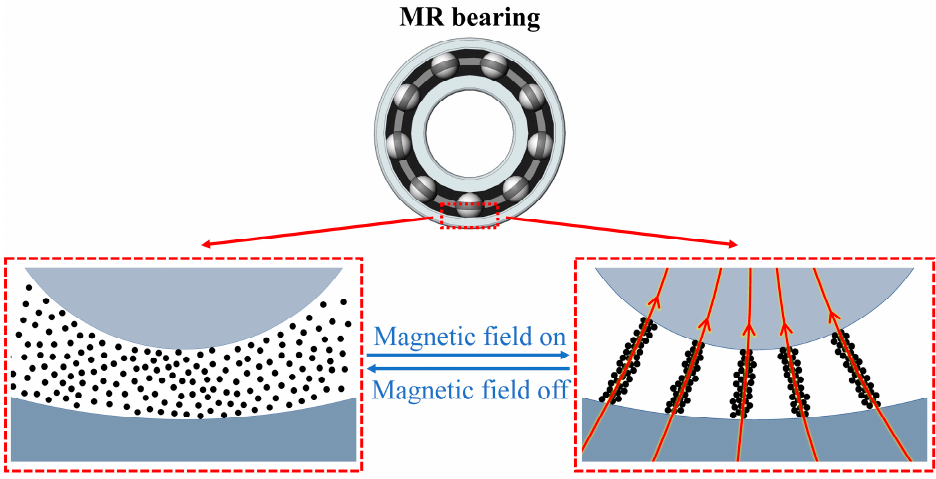
Figure 2. Chain aggregation behavior of the MRG in MR bearings: the blue circle at the top refers to a bearing ball, while the bottom blue part refers to the outer ring of the bearing. Small black circles represent iron powders, and yellow lines with arrows refer to magnetic induction lines.